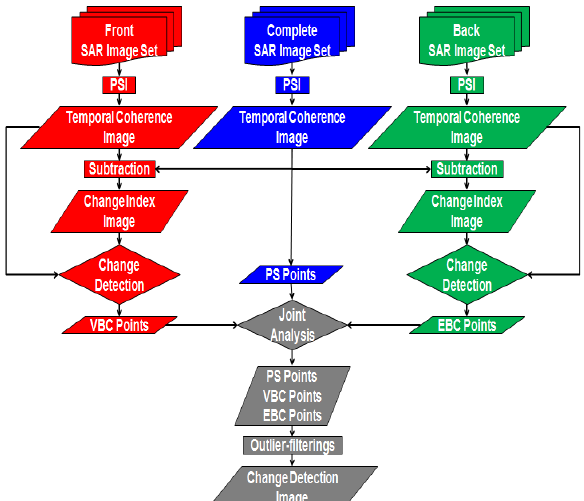
Figure 2. Procedure of CDPSI method. Persistence, vanishment, and emergence scenarios are highlighted in blue, red, and green blocks, respectively. They are dedicated to extract PS, VBC, and EBC points,